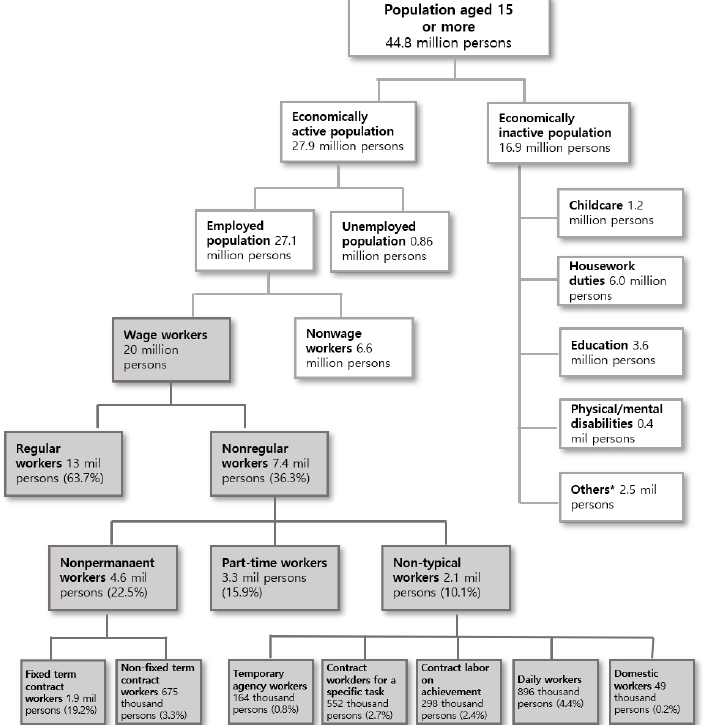
Figure A1. * Others include preparation for employment, preparation for education admission, waiting for military enlistment, break (not in education, employment or training). Source: Ministry of Employment and Labor [74–76].